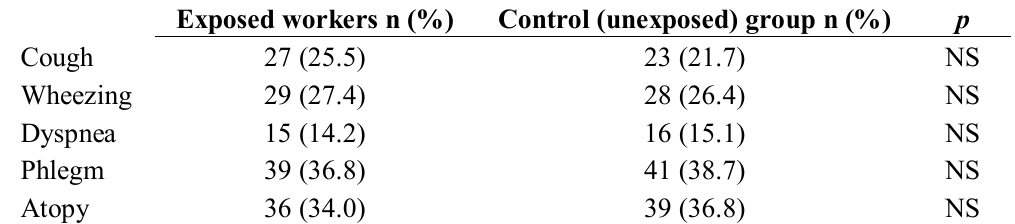
Table 2. Respiratory symptoms among the exposed workers and the control (unexposed) group. Exposed workers n (%)